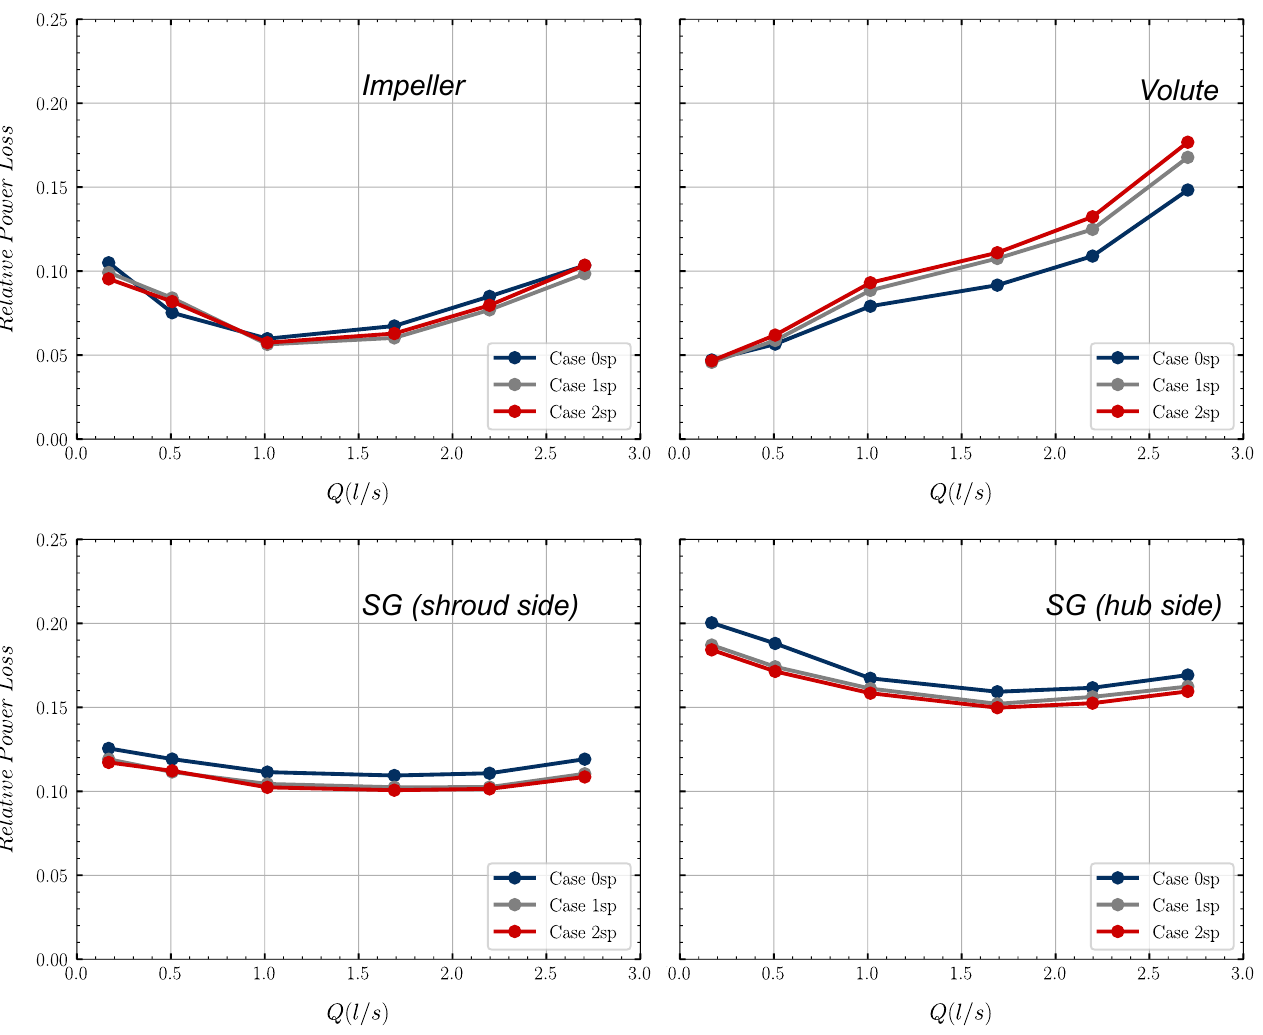
Figure 12. Scaled relative losses per